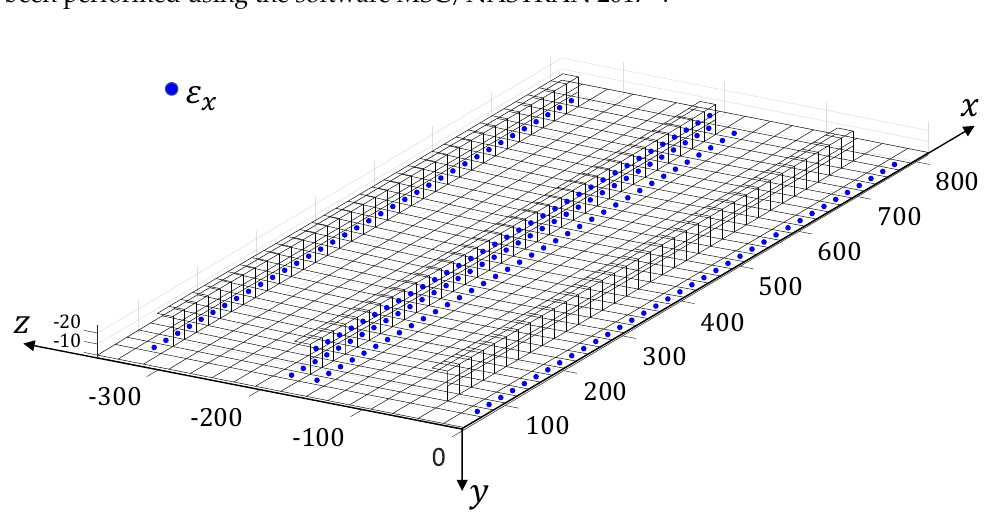
Figure 7. The iFEM mesh and strain sensors’